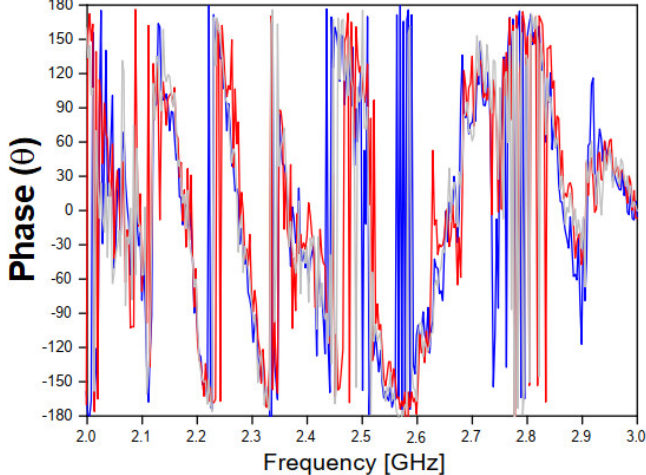
Figure 9. Measured results of the phase of the transmission coefficient for the three concrete block samples.